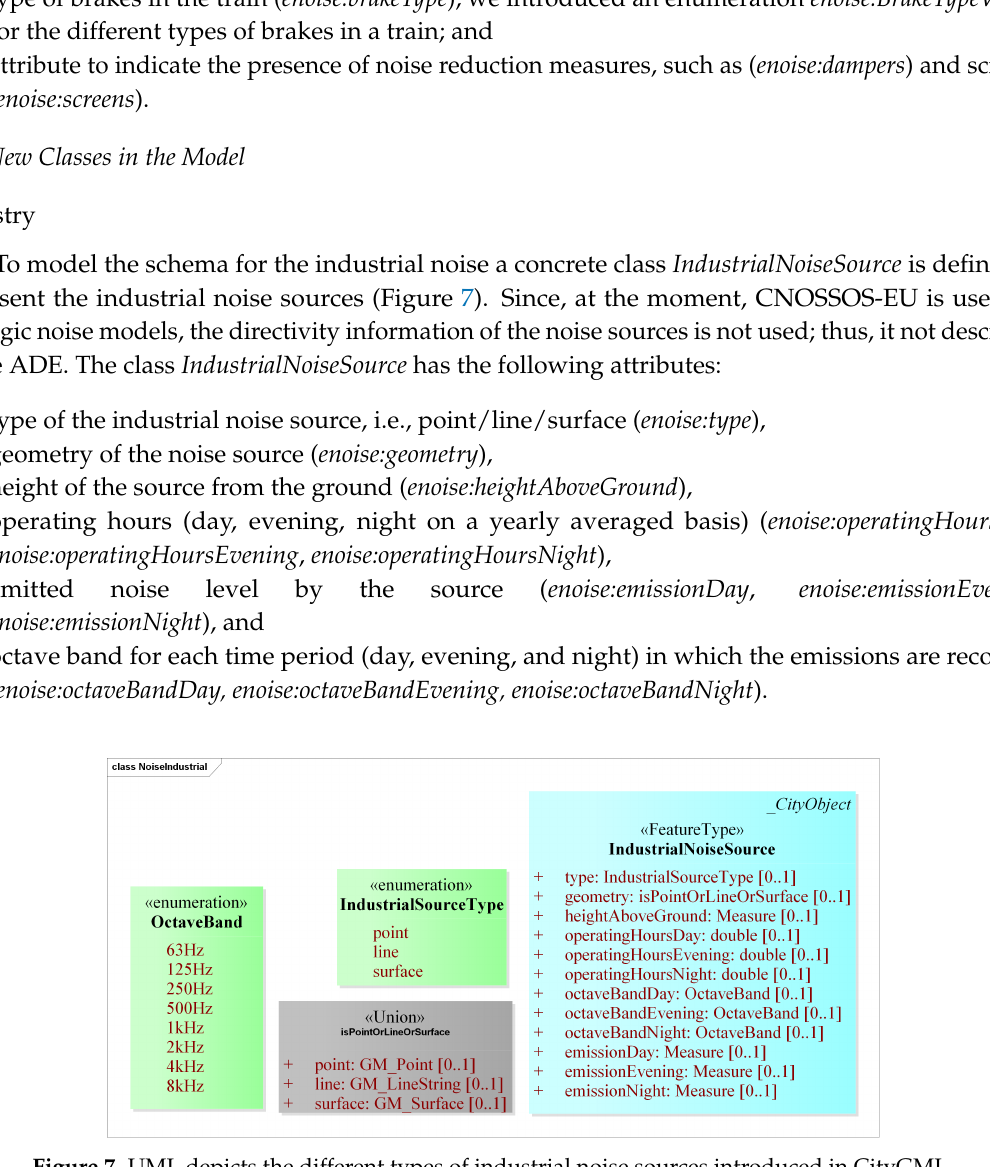
Figure 7. UML depicts the different types of industrial noise sources introduced in